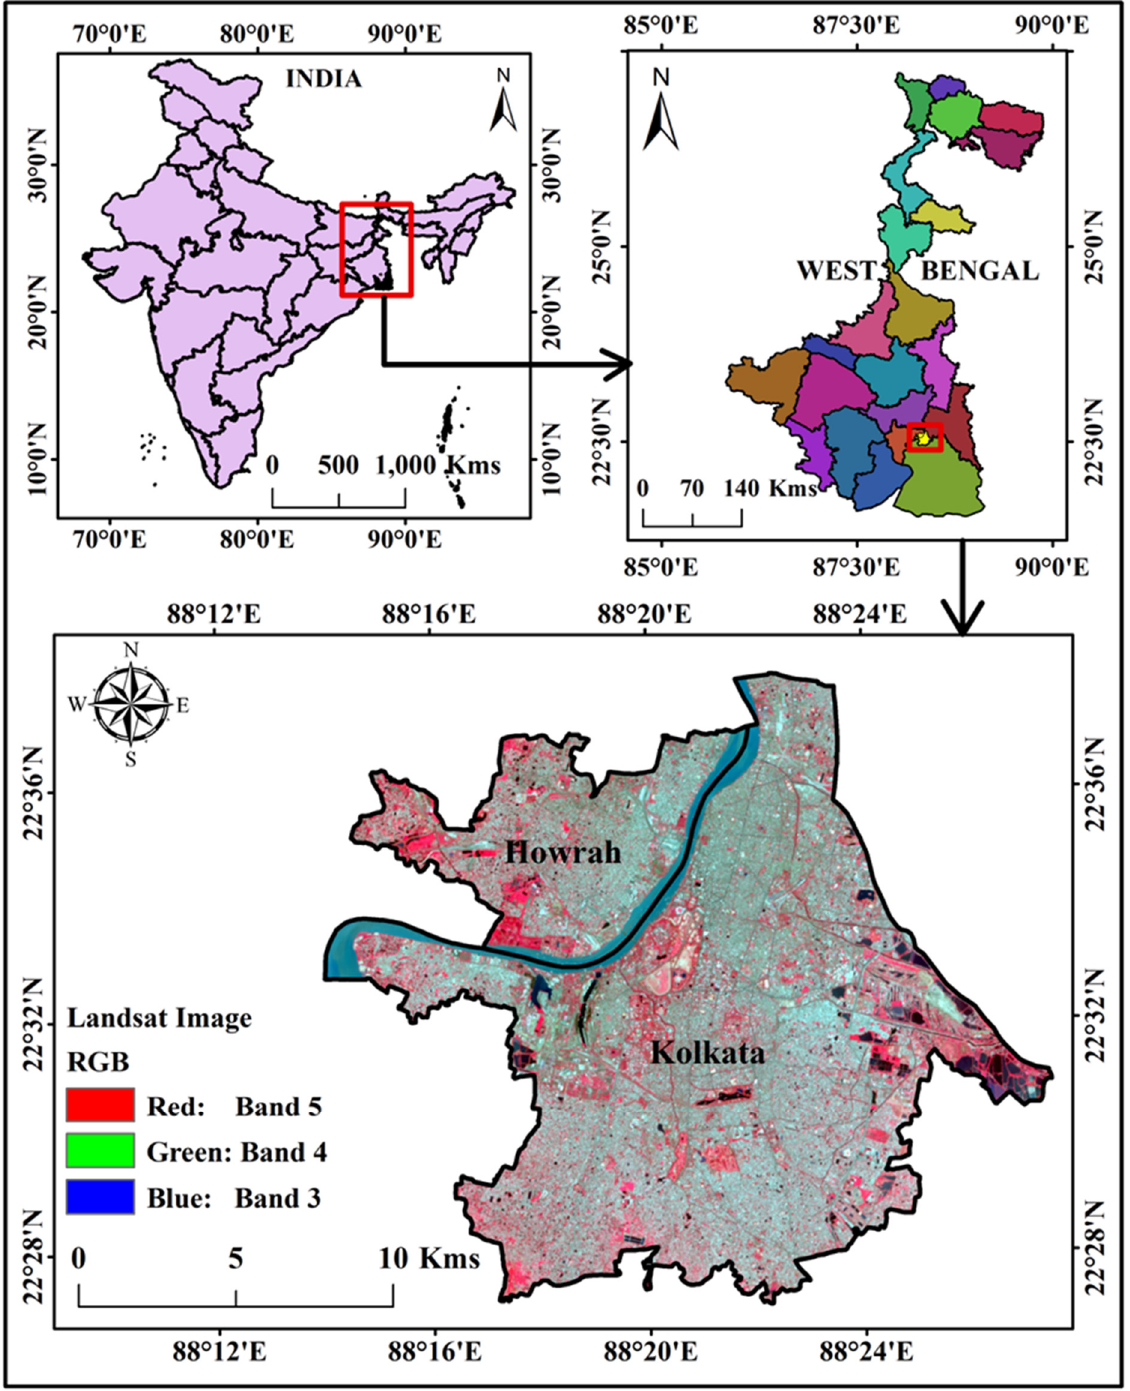
Figure 2. Locational map of the study area showing the twin cities of West Bengal (Kolkata and